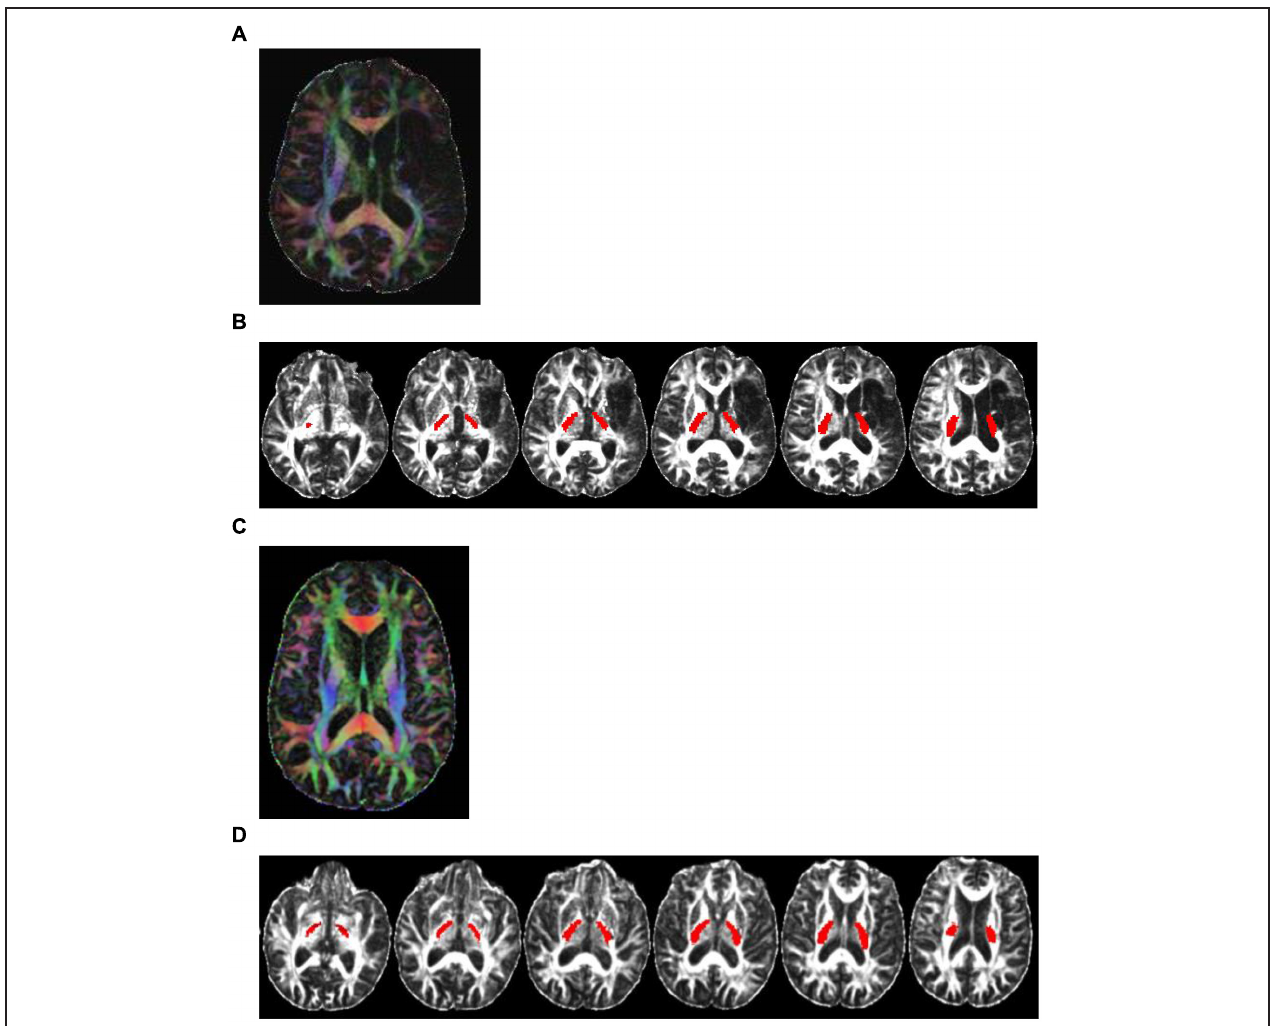
FIGURE 1 | Color-coded diffusion tensor imaging (DTI) images and the PLIC white-matter tract. Directionally encoded color (DEC) map of DTI images and the PLIC white-matter tract. (A) A DTI image of a representative patient (CI001) with damage to PLIC. Color codes to give diffusion tensor directions: red represents tracts running left to right; green is anterior to